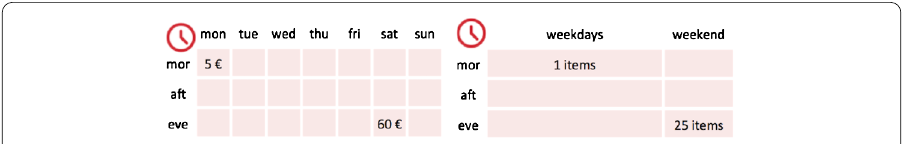
Figure 2 Temporal purchasing units. Examples of temporal purchasing units with different day-intervals and relevance: (left) single day and money spent, (right) weekdays-weekend and number of